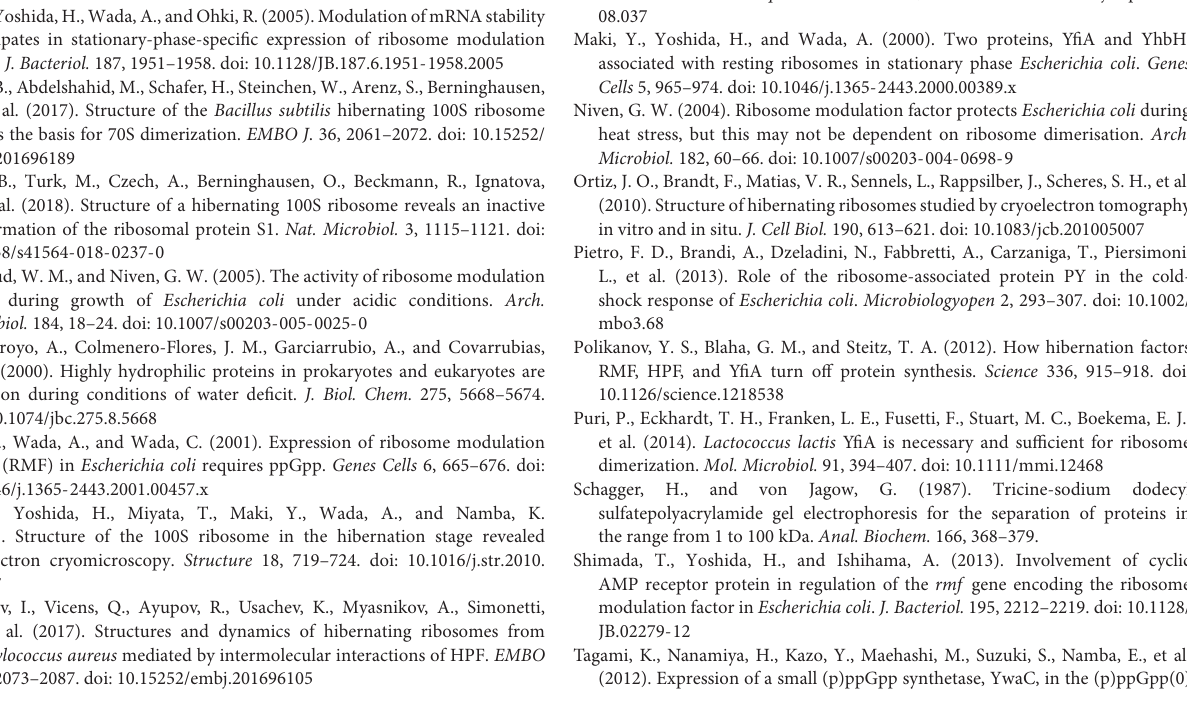
the pRham-01 plasmid (see Table 1 ), cultivated in a medium containing 0.4% (A–C) or 0.8% (D–F) rhamnose, were harvested after 6 h (A,D) , 9 h (B,E) , or 24 h (C,F) of culture. The ribosome profiles were analyzed by the SDGC method. Supplementary Figure 3 | Ribosome profiles of the strains harboring the plasmids shown in Table 1 . (A1,A2) Represent parental and mutated strain lacking key factors for 100S ribosome formation, respectively. (A3) Represents strain expressing intact rmf and hpf genes. (B1–B6) Represent strains expressing RMF with N- or C-terminal truncations. (C1–C13) Represent strains in which the conserved amino acids RMF were replaced by alanine (A). (D1–D8) Represent strains expressing RMF mutated for incompletely conserved amino acids. Figures 2–4 refer to these data. The double-headed arrows indicate the fractionated regions ( (cid:172) 70S and (cid:173) 100S ribosomal fractions) that were analyzed by western blot (see Supplementary Figure 4 ). Supplementary Figure 4 | Western blotting analysis of mutant RMF and intact HPF binding to ribosomes. RMF and HPF in the 70S and 100S ribosomal fractions (see double-headed arrows in Supplementary Figure 3 ) were detected using the appropriate rabbit antisera. Each experiment was conducted multiple times. (A1–B4) Represent detection by anti-RMF antibodies. These results were used to determine the efficiency of ribosome binding, as shown in Table 2 . (C1–C4) Represent detection by anti-HPF antibodies. Supplementary Figure 5 | The mutant RMFs were detected using the appropriate rabbit antisera before the strong degradation by use of the harvested cells an hour after induction. RplB (ribosomal protein L2) was also detected for reference. Supplementary Figure 6 | Position of the conserved amino acids in the structure of RMF from Vibrio parahaemolyticus (PDB ID: 2JRM). (A1,B1) Are shown in the ribbon model. In (A2,B2) , the conserved amino acids are displayed by the ball model. The colors represent the hydropathy index. (A,B) Represent the amino acids shown in Figure 6 , rotated by 90 ◦ with respect to the horizontal axis. Supplementary Figure 7 | Structural superposition of RMF from NMR (PDB ID: 2JRM, Magenta), X-ray (PDB ID: 4V8G, Blue), and Cryo-EM (PDB ID: 6H4N,